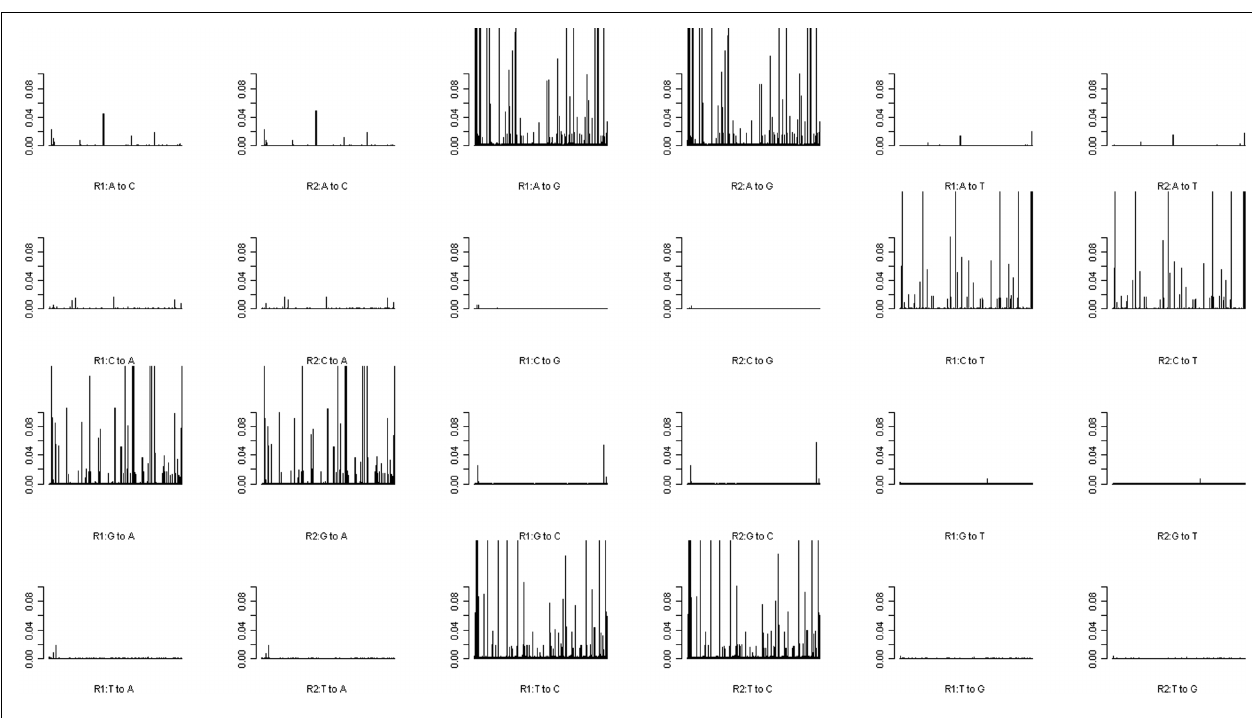
FIGUREA1 | Position-specific base-calling error rates for Pre-PCR.